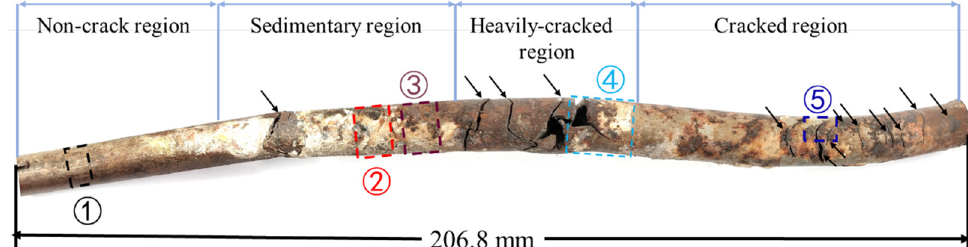
Figure 2. The optical photograph of the failed tube and sampling positions for tests. The black arrows point to the macroscopic cracks on the tube wall. The boxes framed the location of the specimens for detailed analysis.